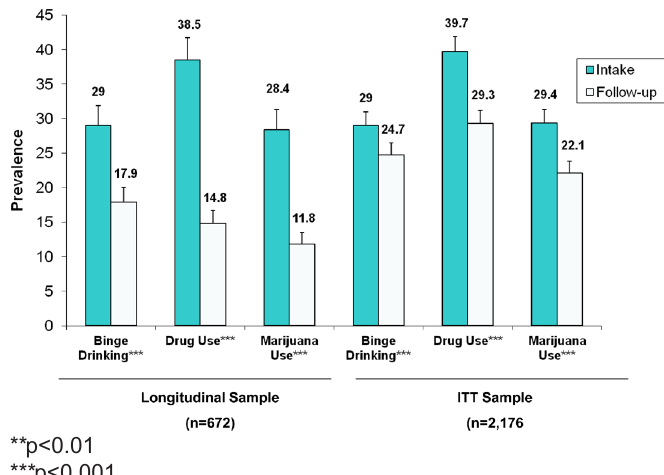
Figure 2. Overall changes in prevalence of past 30 day binge drinking, illicit drug use, and marijuana use in the longitudinal sample and intent-to-treat sample